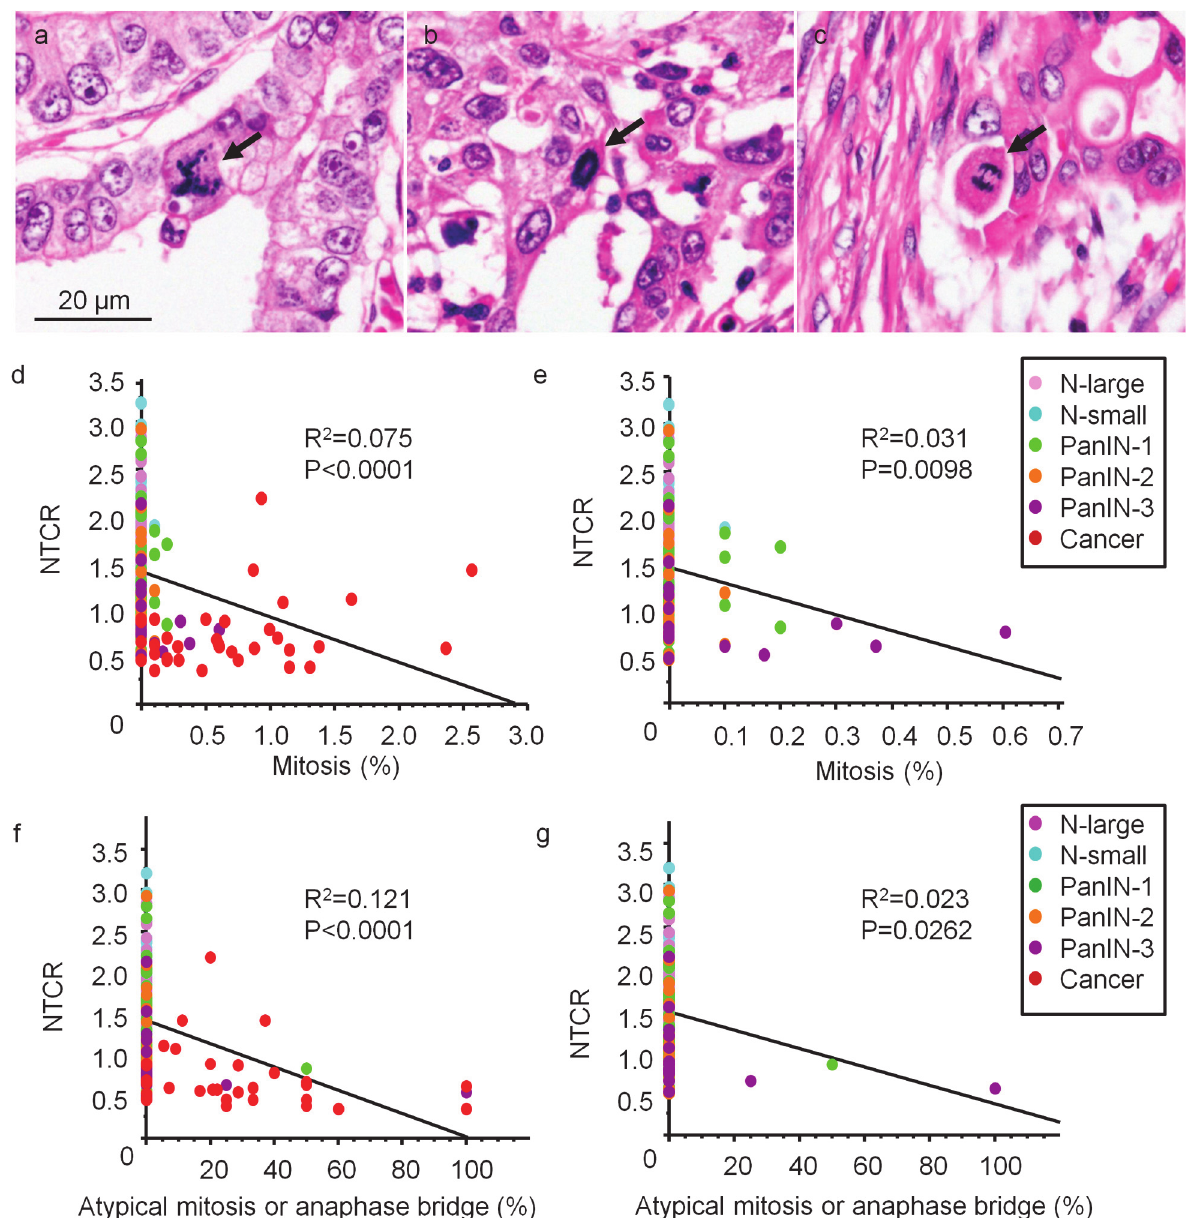
Fig 2. Relationship between telomere length and presence of atypical mitotic figures including anaphase bridges. (a-c) Representative atypical mitotic figures. Arrows indicate multipolar mitosis (a), ring mitosis (b), and an anaphase bridge (c). (d and e) Correlation between NTCR and mitosis for the lesions as a whole (d) and overall minus cancer (e). Data are shown as the percentage of total mitotic Figures among the total cell count. (f and g) Correlation between NTCR and percentage of atypical mitoses or anaphase bridges among the lesions as a whole (f) and overall minus cancer (g). Data are shown as the percentage of atypical mitoses or anaphase bridges among the total number of mitotic